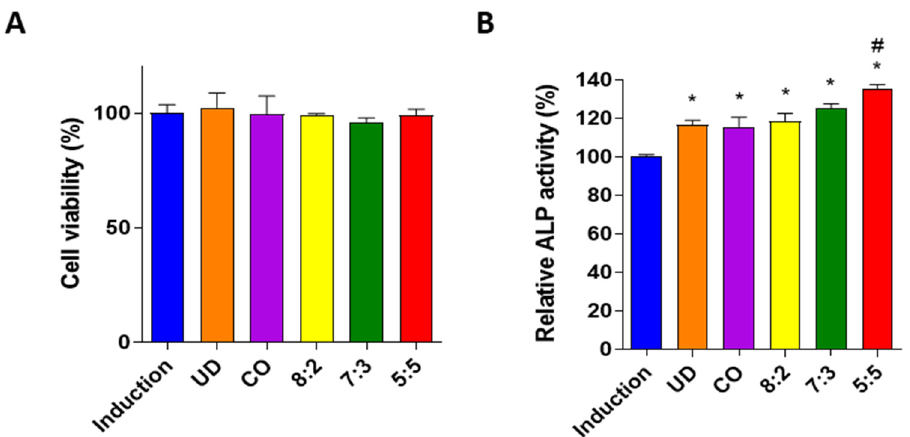
Figure 1. Effects of Ulmus davidiana (UD) and Cornus officinalis (CO) extract on osteoblast. Pre-osteoblast MC3T3-E1 cells were co-treated with an osteoblast induction medium and 10 µ g/mL of UD, CO extract or their combination (8:2, 7:3 and 5:5). After 3 days, ( A ) cell viability and ( B ) ALP activity were measured. The results on the bar-graph are from three independent experiments. UD, Ulmus davidiana treatment; CO, Cornus officinalis treatment; * p < 0.05 vs. induction; # p < 0.05 vs. 8:2 (one-way analysis of variance (ANOVA) with Tukey’s multiple comparison test).